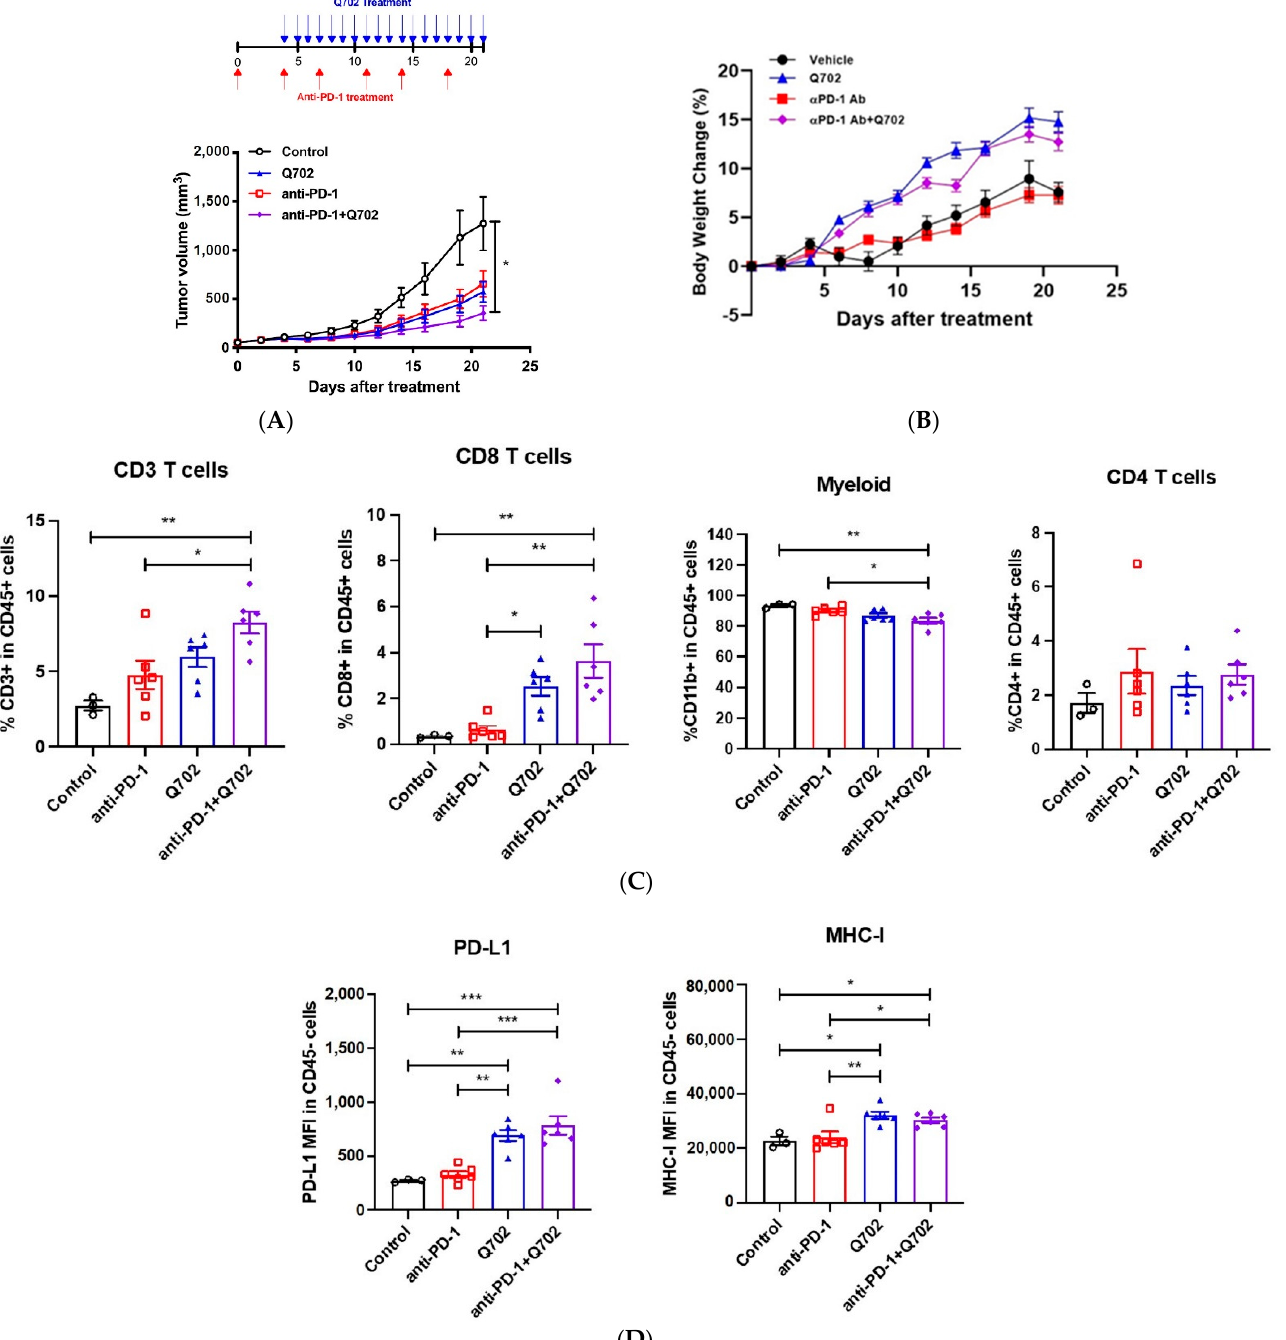
Figure 6. Combined treatment with Q702 and anti-PD-1 antibody inhibits EMT6 tumor growth in vivo. EMT6 (1 × 10 6 ) cells were implanted into the left flank of BALB/c mice. When the tumor size reached 55 mm 3 , mice were randomized and treated with vehicle or anti-PD-1 antibody (10 mg/kg) intraperitoneally twice a week. Four days later, mice were treated with either Q702 (30 mg/kg) orally once daily or with a combination of Q702 and anti-PD-1 antibody. ( A ) Dose schedule and tumor growth in vivo are shown. ( B ) Graph shows changes in mouse body weight over time after treat- ment. ( C and D ) Tumor samples were collected on day 21 post-dosing and immune profiling was performed. ( C ) Graphs show the percentages of tumor-infiltrating CD3 T (CD3 + ), CD8 T (CD3 + CD8 + ), CD4 T (CD3 + CD4 + ), and myeloid (CD11b + ) cells. ( D ) Graphs show PD-L1 and MHC-I expression levels in tumors (CD45-negative cells). * p < 0.05, ** p < 0.01, *** p < 0.001, one-way ANOVA.